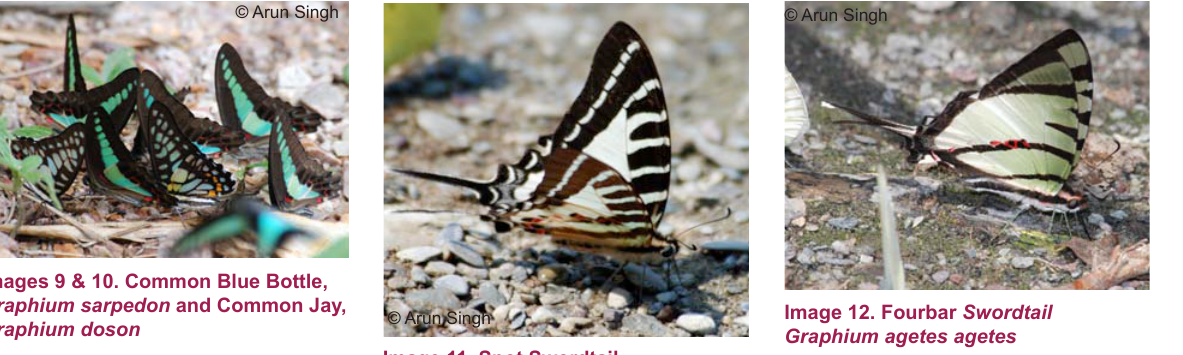
Image 11. Spot Swordtail Graphium nomius